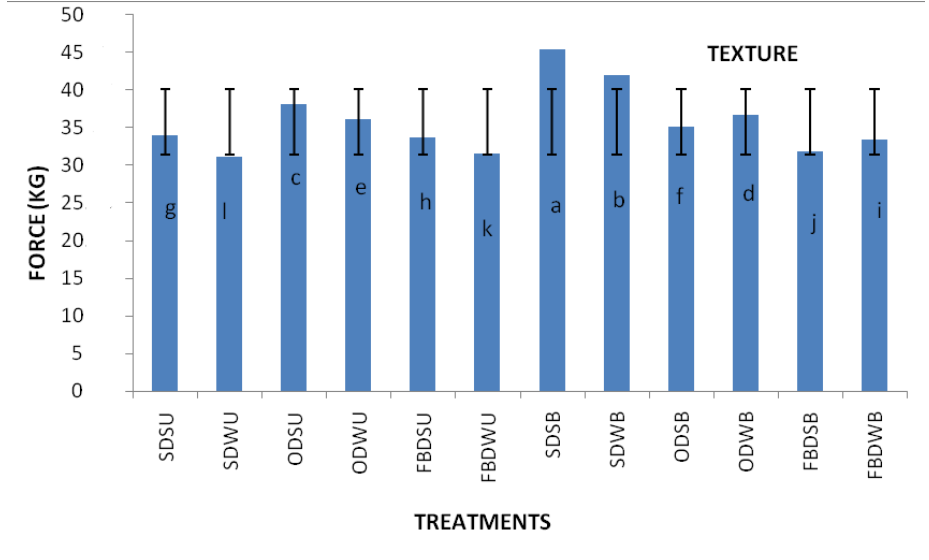
Figure 3. Textural changes in Turmeric with methods of drying. All values are Mean ± S D ( n = 3). The whiskers denote the corresponding SDs. Lowercase letters inside the bars indicate significant differences among the treatments ( p ≤ 0.05). SDSB: Sun Dry Slice Boiled, SDWB: Sun dry whole